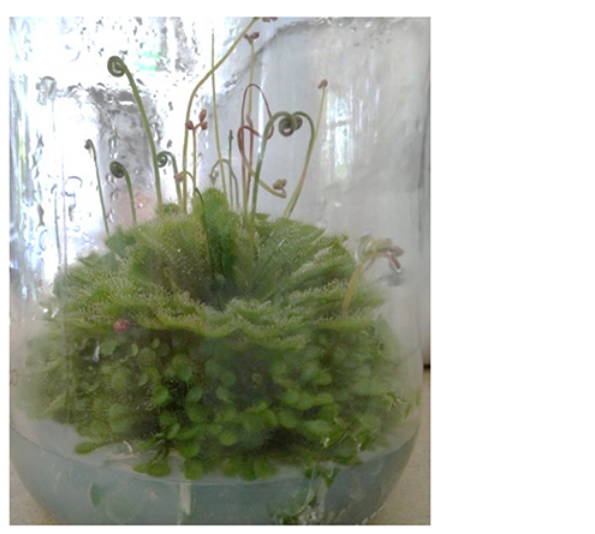
Figure 9 In vitro Drosera spatulata